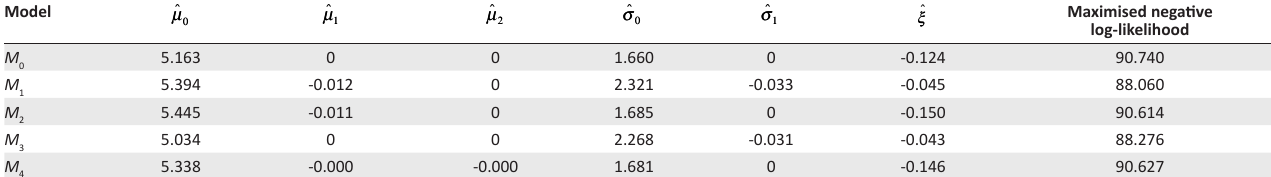
TABLE 2: Annual daily maximum time-dependent generalised extreme value models for Combomune for the period 1966–2010. Model